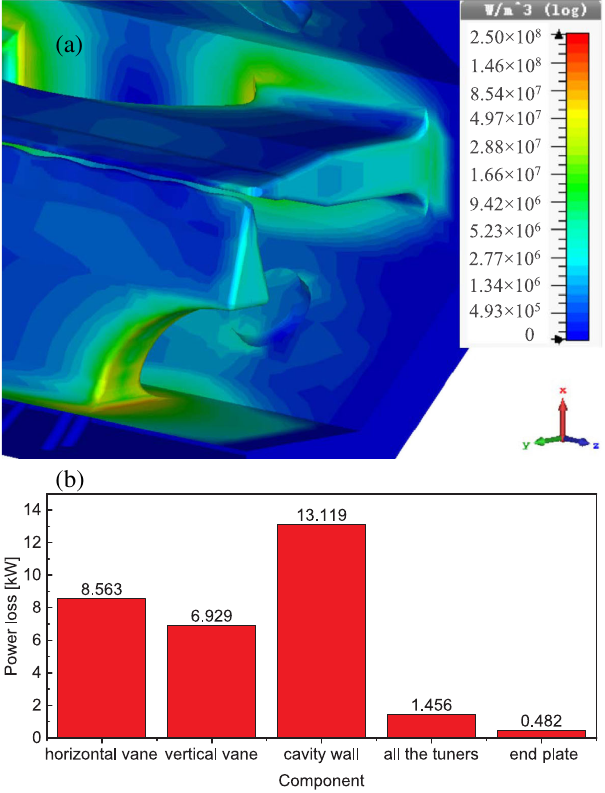
FIG. 25. (a) Power density and (b) power loss for RFQ components, with the intervane voltage normalized to 60 kV.